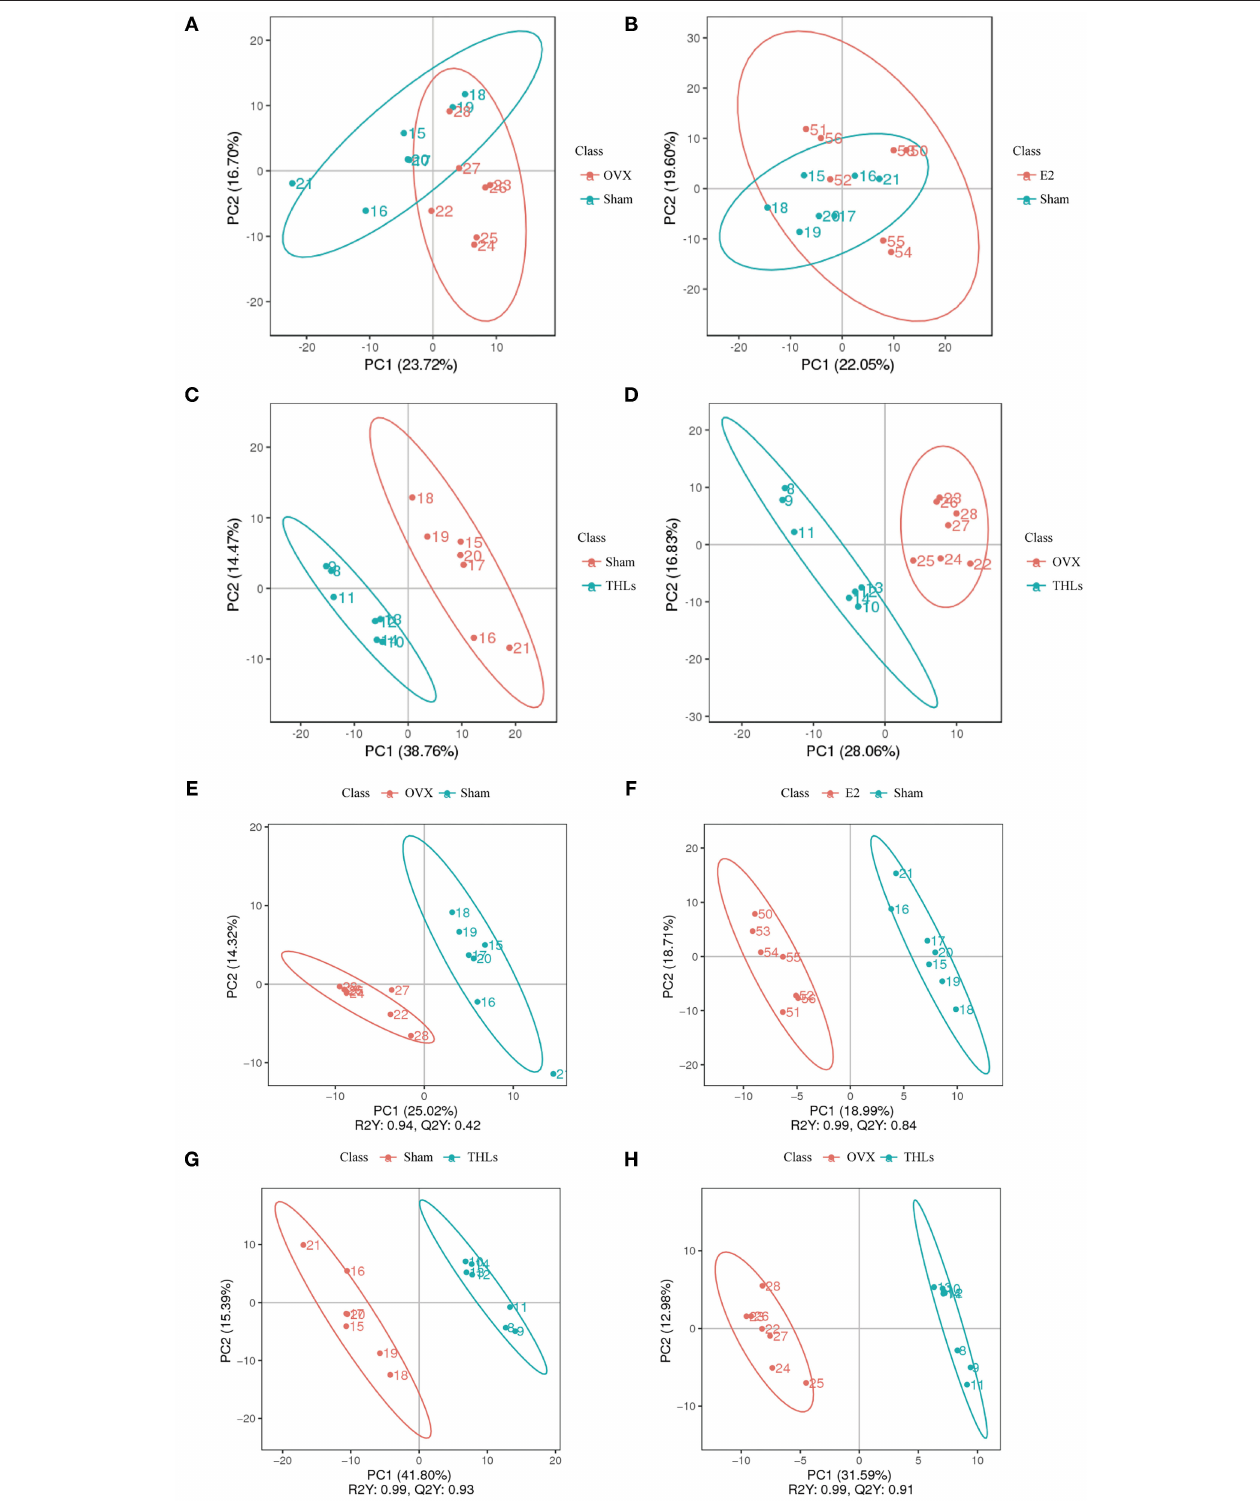
FIGURE 5 | The serum metabolism of rat was changed by THLs. PCA and the partial least squares discriminant analysis (PLS-DA). (A) OVX vs. Sham; (B) E2 vs. Sham; (C) Sham vs. THLs; (D) OVX vs. THLs; (E) OVX vs. Sham; (F) E2 vs. Sham; (G) Sham vs. THLs; (H) OVX vs. THLs; the abscissa PC1 and ordinate PC2 represent the scores of the first and second principal components, respectively. R2Y represents the interpretation rate of the model, Q2Y is used to evaluate the predictive ability of PLS-DA model, and when R2Y is greater than Q2Y, it means that the model is well-established.